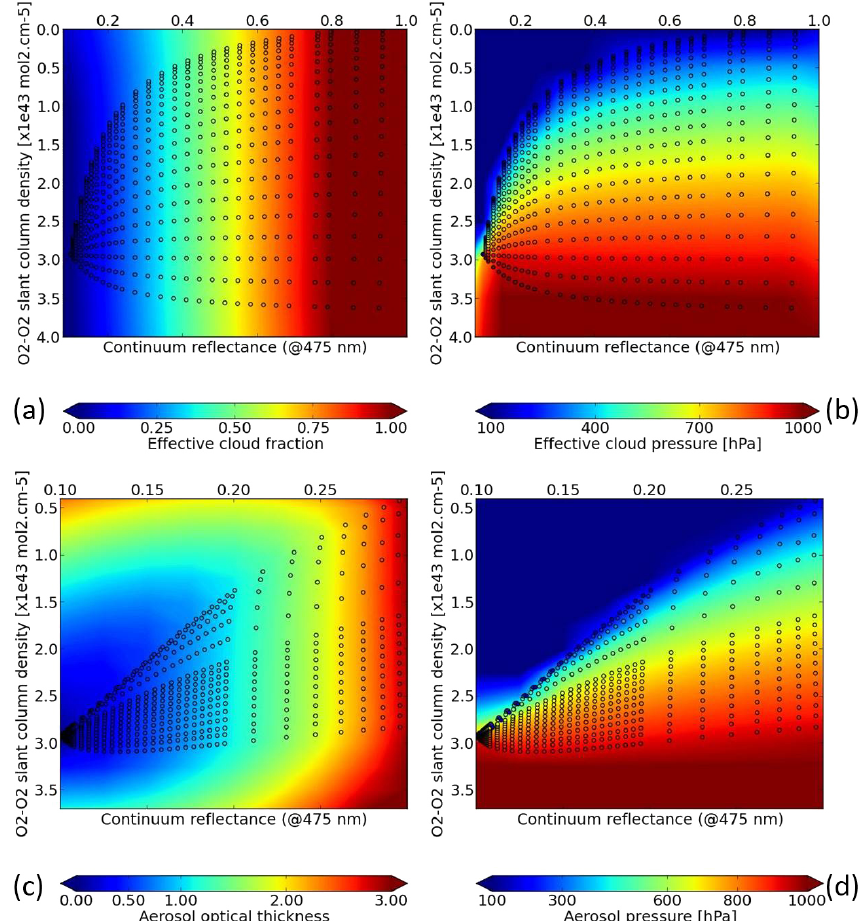
Figure 13. Effective cloud (Lambertian reflector, albedo = 0.8) and fine scattering aerosol ( α = 1.5, ω 0 = 0.95, g = 0.7) parameters as a function of O 2 − O 2 slant column density and continuum reflectance at 475nm for the following conditions: climatology mid-latitude summer temperature, NO 2 , O 3 , and H 2 O profiles, surface albedo = 0.05, SZA = 32 ◦ , VZA = 32 ◦ , and surface pressure = 1013hPa. The dots are the values specified (see Table 2) in the forward simulations (named simulation nodes). The background colours result from the linear interpolation / extrapolation of the DOAS fit results: (a) effective cloud fraction, (b) effective cloud pressure [hPa], (c) aerosol optical thickness at 550nm, (d) aerosol pressure